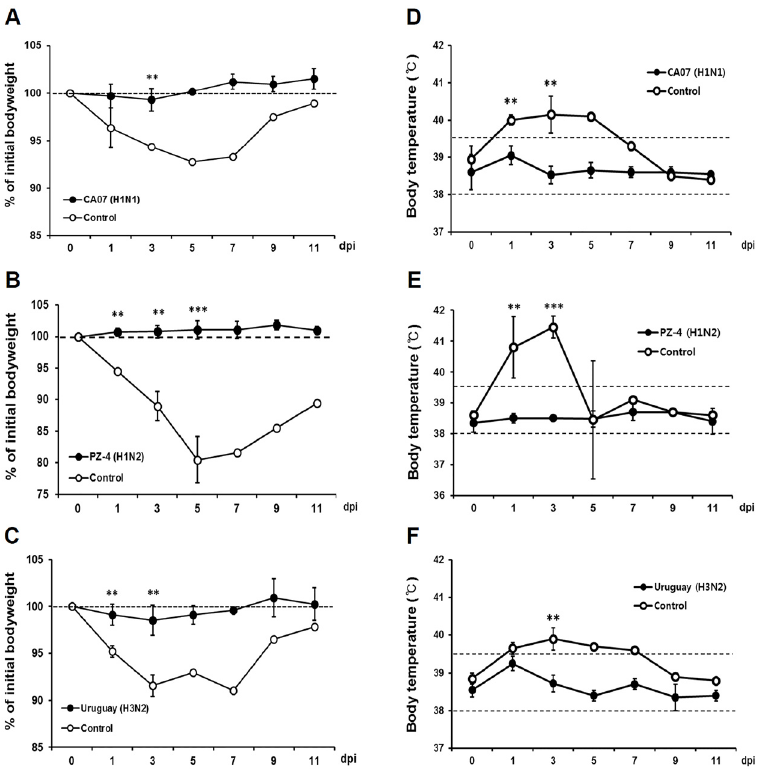
Fig 2. Eyedrop influenza vaccine protects ferrets from influenza virus challenge. At two weeks after the last eyedrop vaccination, ferrets were challenged i.n. with 1 × 10 5 TCID50 of CA04 (H1N1) on CA07 (H1N1) LAIV-vaccinated group (A, D) or 1 × 10 6 TCID50 of Sw09 (H1N2) or HK69 (H3N2) on PZ-4 (H1N2) LAIV- vaccinated (B and E) or Uruguay (H3N2) LAIV-vaccinated (C and F) group, respectively. Body weight (A-C) and body temperatures (D-F) were monitored for 11 days with an interval of two days. Dotted lines in figures D-F: normal body temperature range. ** p < 0.01, *** p < 0.001 compared with the findings in the PBS control group (n = 3 for each group). Statistical analyses were conducted by the student ’ s t-test .